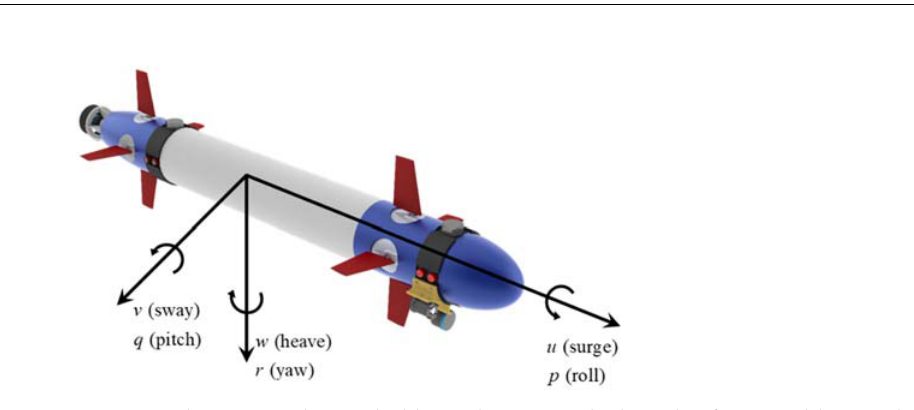
Figure 1. The proposed torpedo-like underwater vehicle with 4 fins, 4 rudders, and 1 non-rotatable thruster.